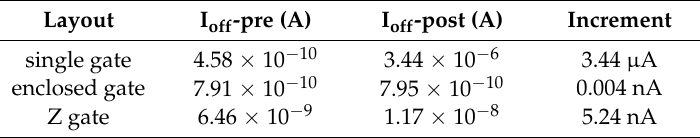
Table 3. I off in the pre- and post-radiation